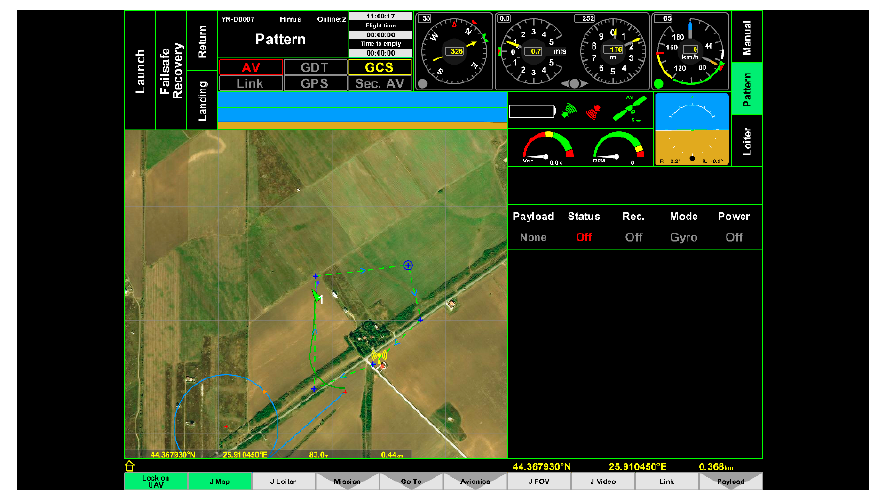
Figure 12. Pattern mode (tracking segments = green dashed line). Green arrow = UAV.